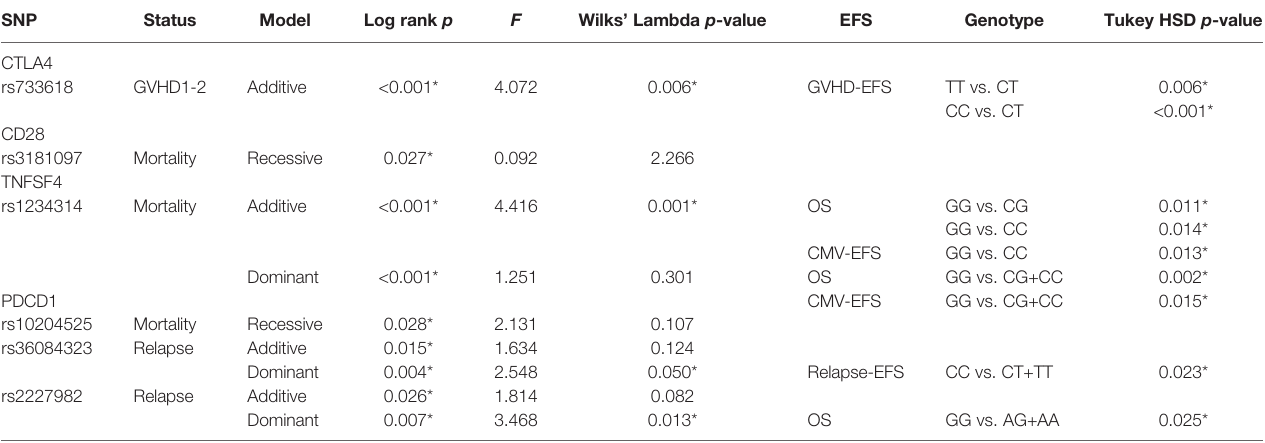
TABLE 9 | Summarized the signi fi cant results of log rank test, Wilks ’ Lambda, and post-hoc